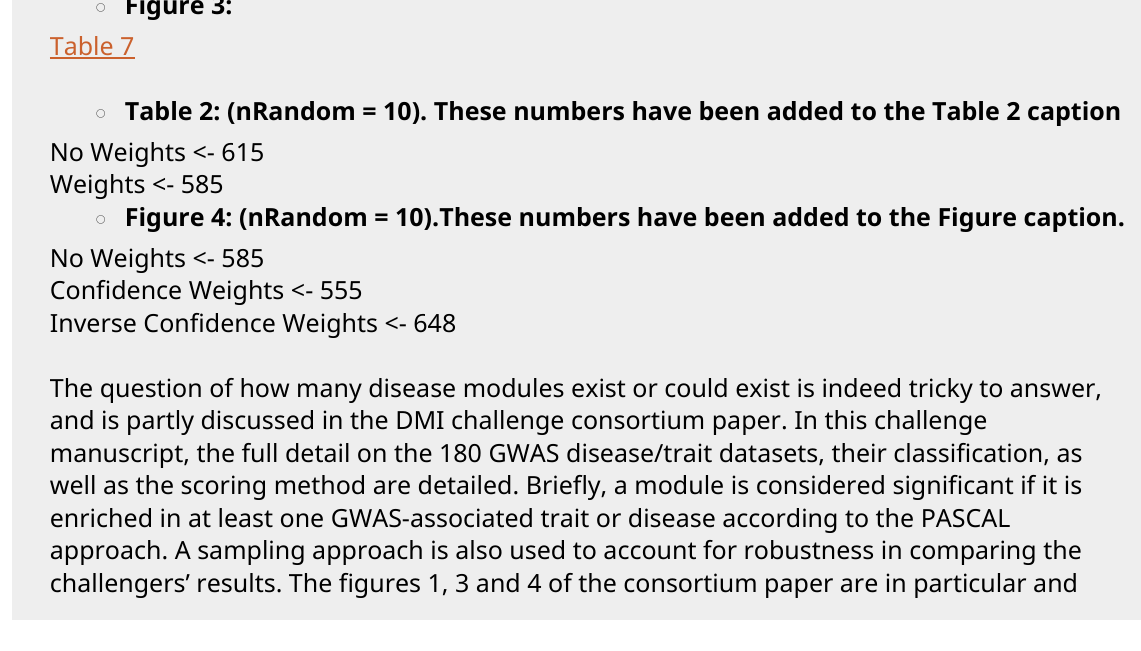
Table 2: (nRandom = 10). These numbers have been added to the Table 2 caption ○